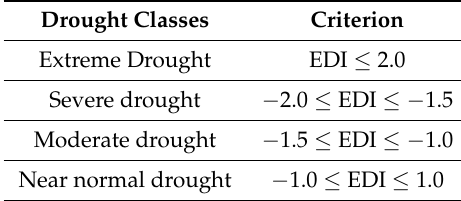
Table 2. EDI classification table